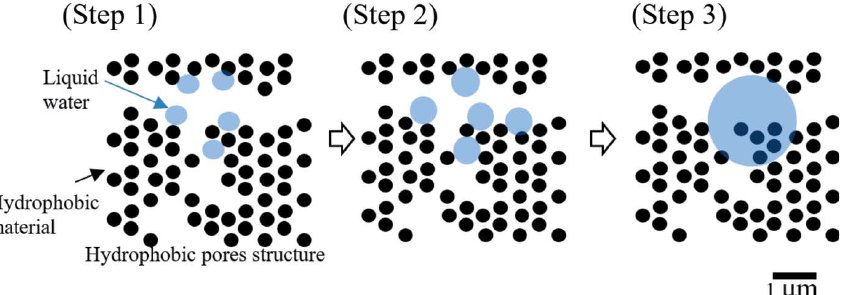
Figure 8 Schematic images of water droplet growth and aggregation model, which is the mechanism for the formation of liquid water in a hydrophobic pore structure. (Step 1) Liquid water droplets less than 1 m m in diameter condense at locations in the hydrophobic porous material. (Step 2) The water droplets grow with a spherical shape. If there are water droplets nearby, then they possibly coalesce when they come into contact with each other. (Step 3) The spherical shape of the liquid water droplets is stable, and the droplets surround hydrophobic